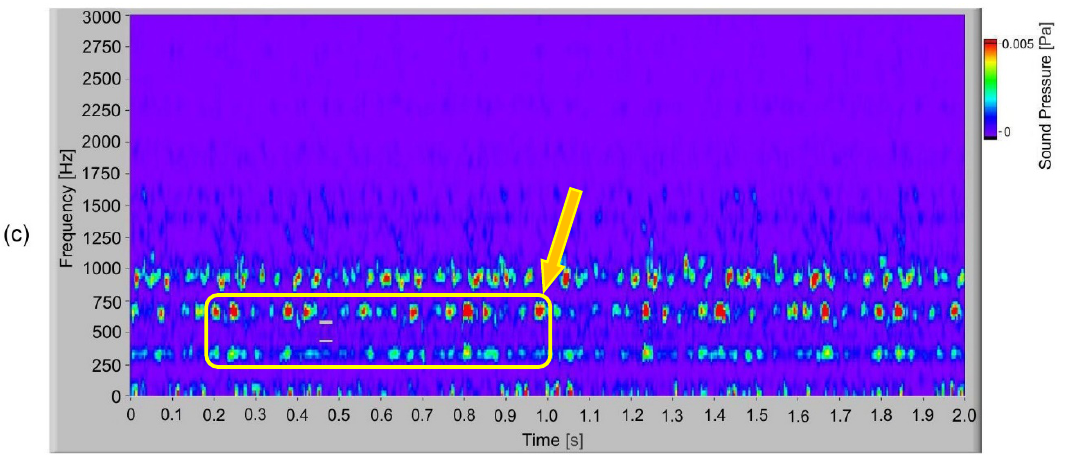
Figure 10. Frequency spectrogram of sound signal for E-gears: ( a ) T = 1.5 Nm; ( b ) T = 1.3 Nm; ( c ) T = 1.1 Nm.